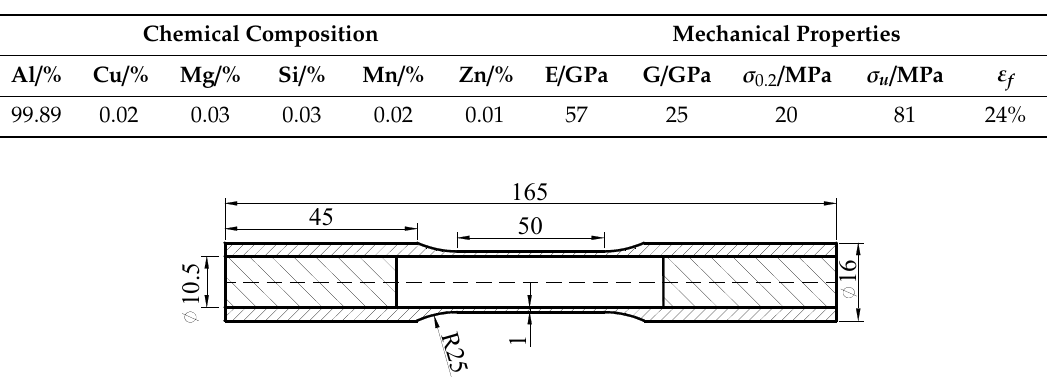
Figure 2. Specimen geometry of pure aluminum (unit: mm). Table 1. Chemical compositions and mechanical properties of polycrystalline aluminum.